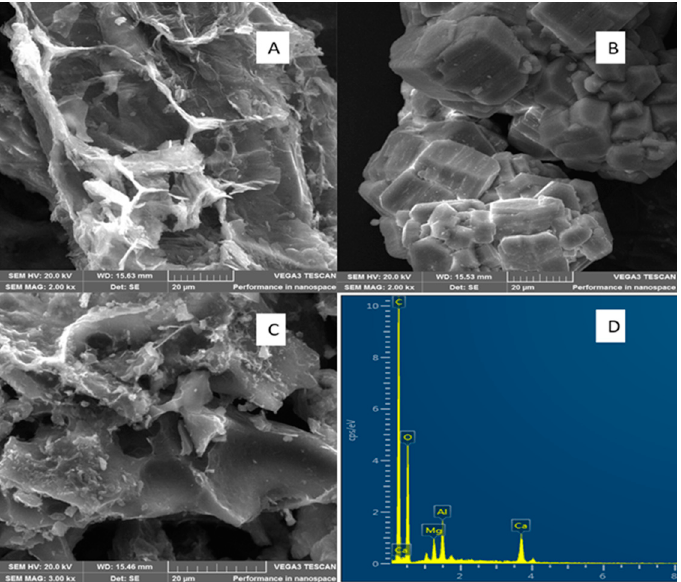
Figure 2. SEM image of ( A ) BPAC, ( B ) Al 2 O 3 , ( C ) BPAC@Al 2 O 3 @chitosan, and ( D ) SEM-EDX